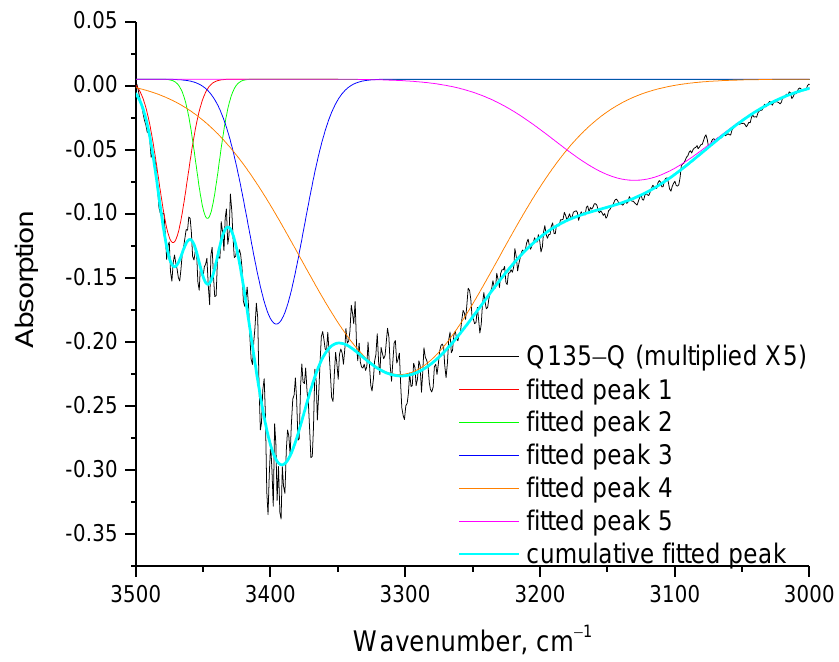
Figure 5. Fitting of the peak of the subtracted spectrum (Q135-Q) presented in Figure 3a in the range 3000–3500 cm − 1 with 5 Gaussian peaks. Table 2. Wavenumber and % area of the five fitted peaks presented in Figure 5.